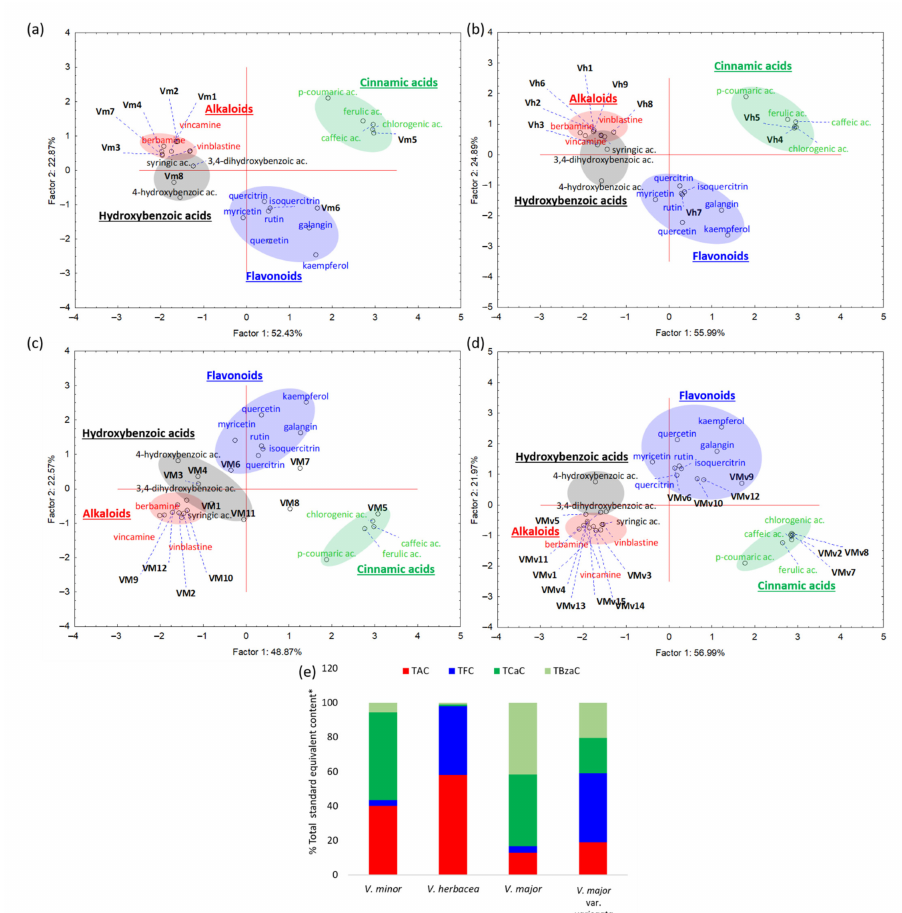
Figure 2. Chemo-mapping of the major chromatographic peaks—phytoconstituents classification—based on spectral similarities for each studied extract using PCA. PCA was applied on exported UV DAD spectra, for each chromatographic peak. Shown here are the scatterplots of the scores for the first two principal components for ( a ) V. minor , ( b ) V. herbacea , ( c ) V. major , and ( d ) V. major var. variegata . The classified compounds are detailed in Table S1. Groups with high similarity are clustered in specific color for each phytoconstituent group or class (grey-hydroxybenzoic acids, green-cinnamic acids, blue-flavonoids, and red-alkaloids); ( e ) Total standard (vincamine for TAC, quercetin for TFC, cynnamic acid for TCaC and benzoic acid for TBzaC) equivalent content (%) for each extract for 230 nm chromatogram, after PCA classification. TAC-total alkaloid content, TFC-total flavonoid content, TCaC-total cinnamic acids content, TBzaC-total hydroxybenzoic acids content, Vm = V. minor , VM = V. major , VMv = V. major var. variegata , Vh = V. herbacea